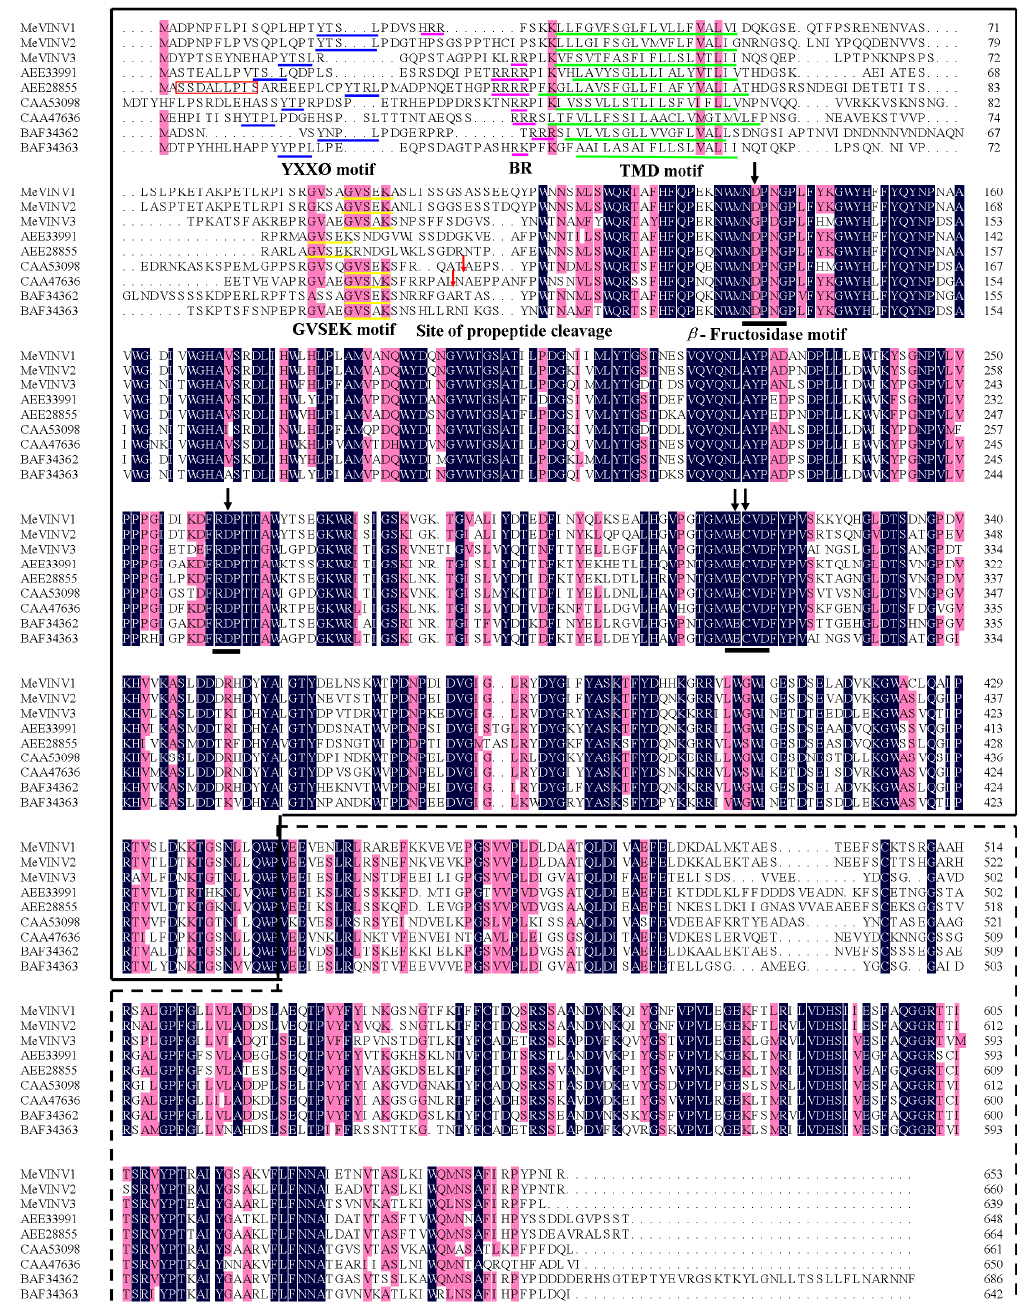
Figure 3. Alignment of the cassava vacuolar invertase amino acid sequences with amino acid sequences from three species. Identical amino acid residues in this alignment are shaded in black, and 75% or more similar amino acid residues are shaded in red. Black lines indicate the motifs which include active sites. Four arrows show the amino acids, which correspond with the active residues of invertase. The blue lines indicate the possible Basic region (BR) motifs. The green lines indicate the predicted transmembrane domain (TMD). Red box indicates the dileucine consensus motif for AtVI2 (AEE28855) [28]. The site of propeptide cleavage is indicated by red arrows. The N-terminus domain sequence is shown in the box (solid line), and the C-terminus domain sequence is also shown in the boxed (dashed